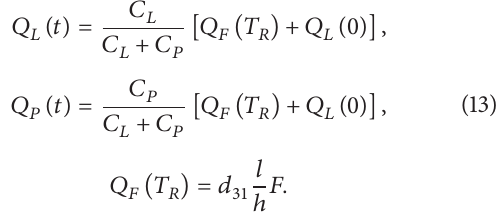
is the force rise time, 𝐹 is the amplitude value, 𝐶 𝐿 is the storage capacitor, and 𝐶 𝑃 is the capacitance of PVDF